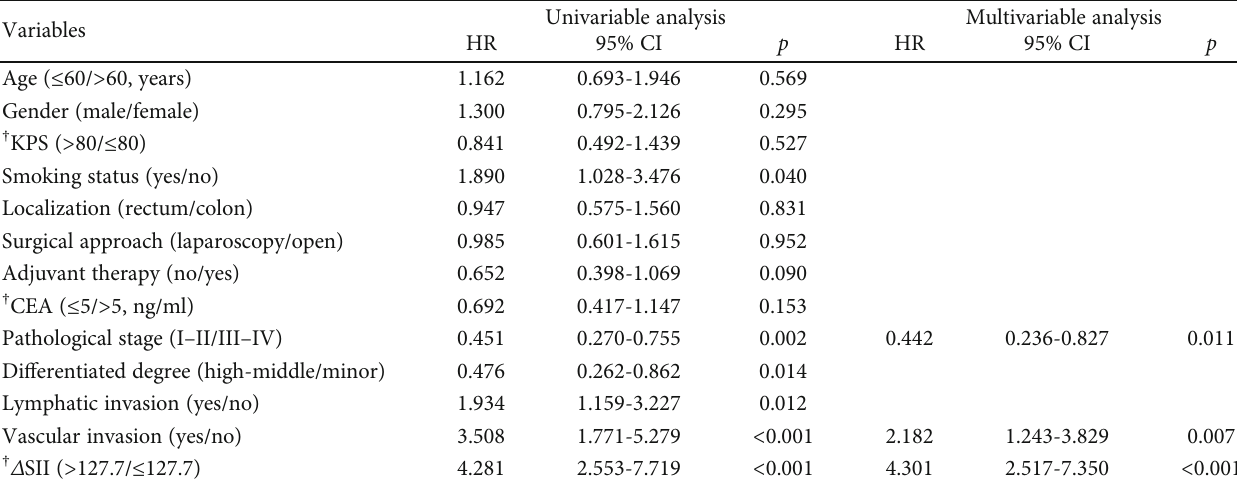
Table 3: Univariable and multivariable analysis for overall survival.